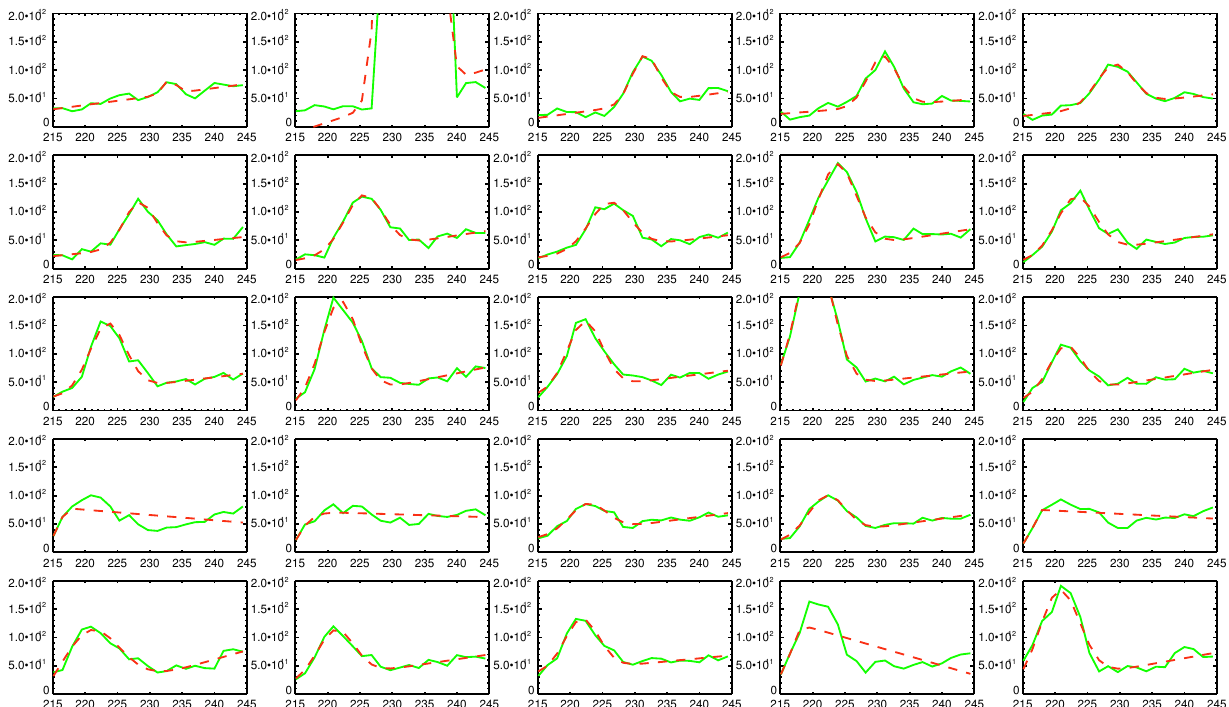
Fig. 10. The altitude profiles of the data for successive 5-s data from just before heater switch-on to heater switch-off. Chronological order is given by going from left to right and then down the page. In each panel, the data are shown using a solid green line and a fitted Gaussian profile is shown using a dashed red line. There is very good agreement between the data and the fitted